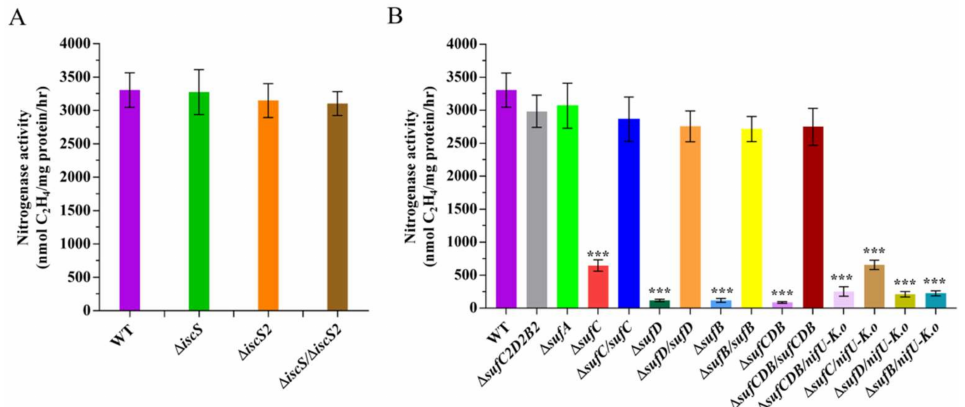
Figure 6. Effect of disruption of iscS and suf genes on nitrogenase activities. ( A ) Nitrogenase activities of wild-type (WT), ∆ iscS (deletion mutant), ∆ iscS2 (deletion mutant), and ∆ iscS/ ∆ iscS2 (double deletion mutant). ( B ) Nitrogenase activities of wild-type (WT), ∆ sufC2D2B2 (deletion mu- tant), ∆ sufA (deletion mutant), ∆ sufC (deletion mutant), ∆ sufC/sufC (complementation strain), ∆ sufD (deletion mutant), ∆ sufD/sufD (complementation strain), ∆ sufB (deletion mutant), ∆ sufB/sufB (com- plementation strain), ∆ sufCDB (deletion mutant), ∆ sufCDB/sufCDB (complementation strain), and ∆ sufCDB/nifU-K.o , ∆ sufC/nifU-K.o , ∆ sufD/nifU-K.o , ∆ sufB/nifU-K.o (complementation by K. oxytoca nifU ). The nitrogenase activities of these strains were assayed by the C 2 H 2 reduction method and expressed in nmol C 2 H 4 /mg protein/hr. The nitrogenase activity of the WT strain was used as a control. Results are representative of at least three independent experiments. Error bars indicate the SD. *** p <